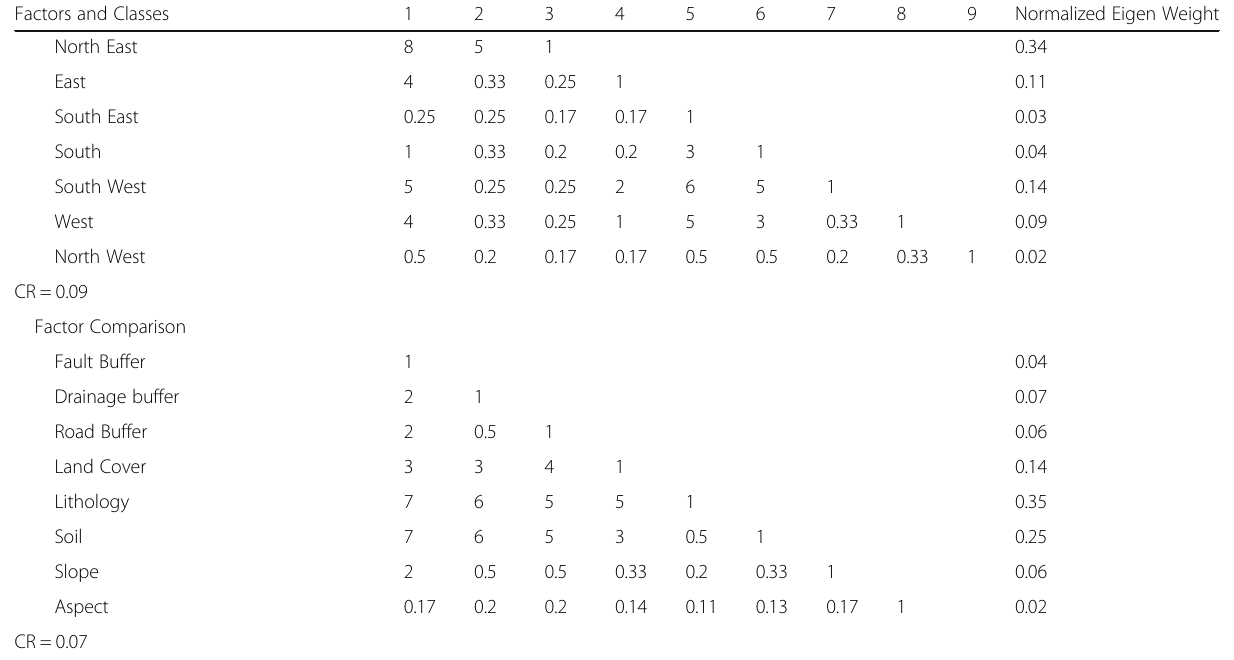
Table 4 Comparison matrix of factor classes and the factors based on analytical hierarchy process (AHP) (Continued) Factors and